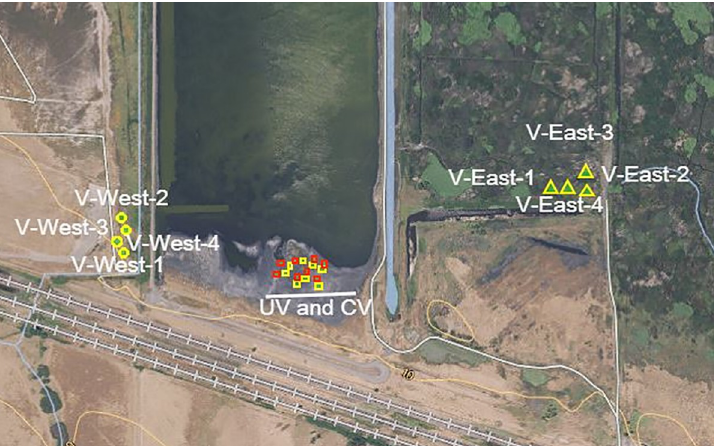
Fig 1. Schematic representation of the sampling sites within solid waste management unit (SWMU) located in Contra Costa County, northern California. A total of twenty-four composite samples were taken at four different areas: 1) Total of eight composite rhizosphere-associated soil samples from pickleweed plants growing on the east (4-samples) and west side (4-samples) of the central SWMU area and referred as peripheral vegetated, V-East (yellow triangles), and V-West (yellow stars) sites, respectively. 2) From the central SWMU sampling site; eight rhizosphere- associated soil samples from pickleweed plants growing within SWMU site (CV, yellow rectangular); and eight bulk soil (un-vegetated) samples within SWMU site away from pickleweed plants rhizosphere (UV, red